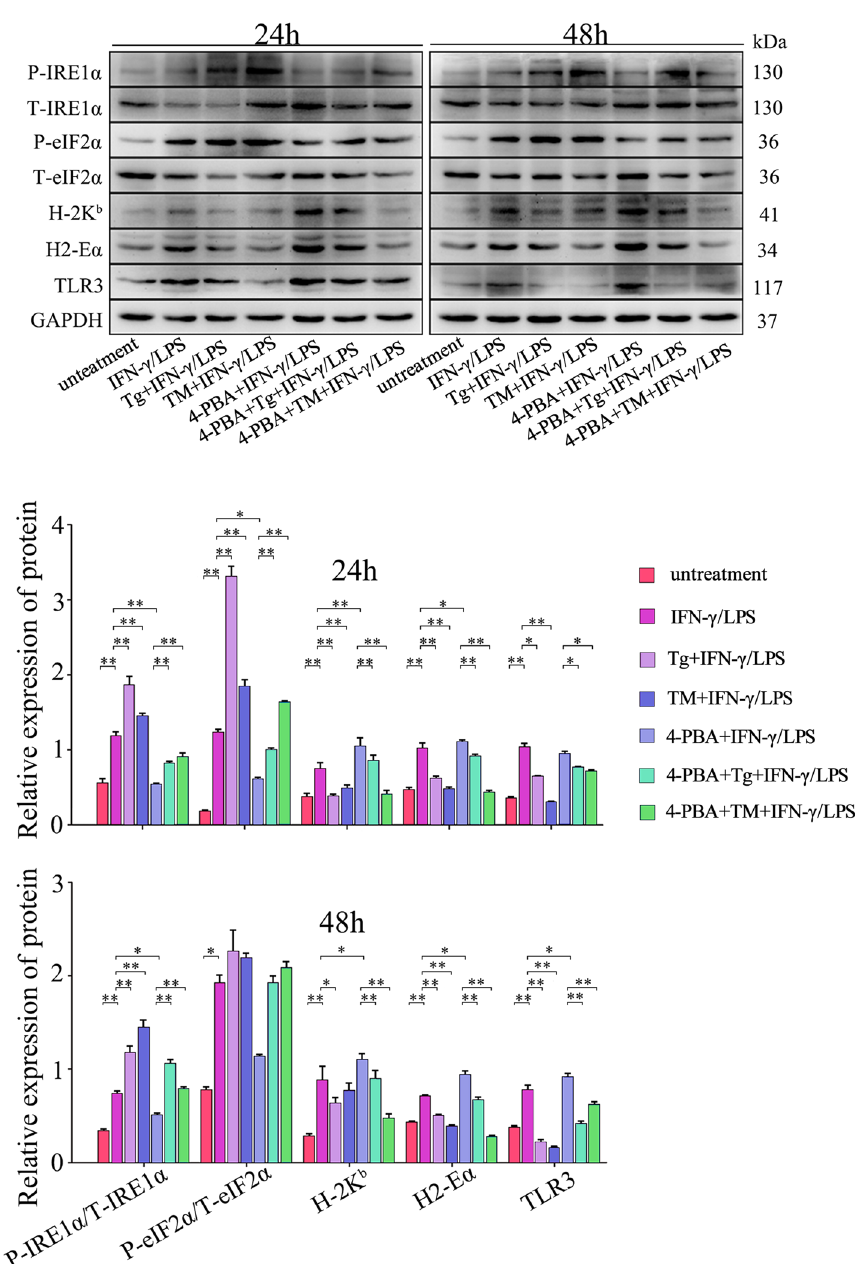
Fig. 5 Intrinsic UPR activity affects muscle cell immune behaviors. The protein expression of the molecules related to immune response in differentiated WT mice MPC-myotubes was analyzed by Western blot. The relative protein levels are expressed as a ratio [protein of interest/GAPDH or phosphorylated (P) protein/total protein]. All data are presented as means SD ( n 3). A one-way ANOVA was used for multiple comparisons ± = (* P < 0.05; ** P <